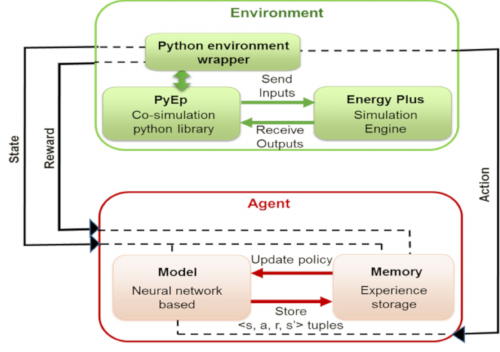
Figure 4. Environment and agent interactions process.